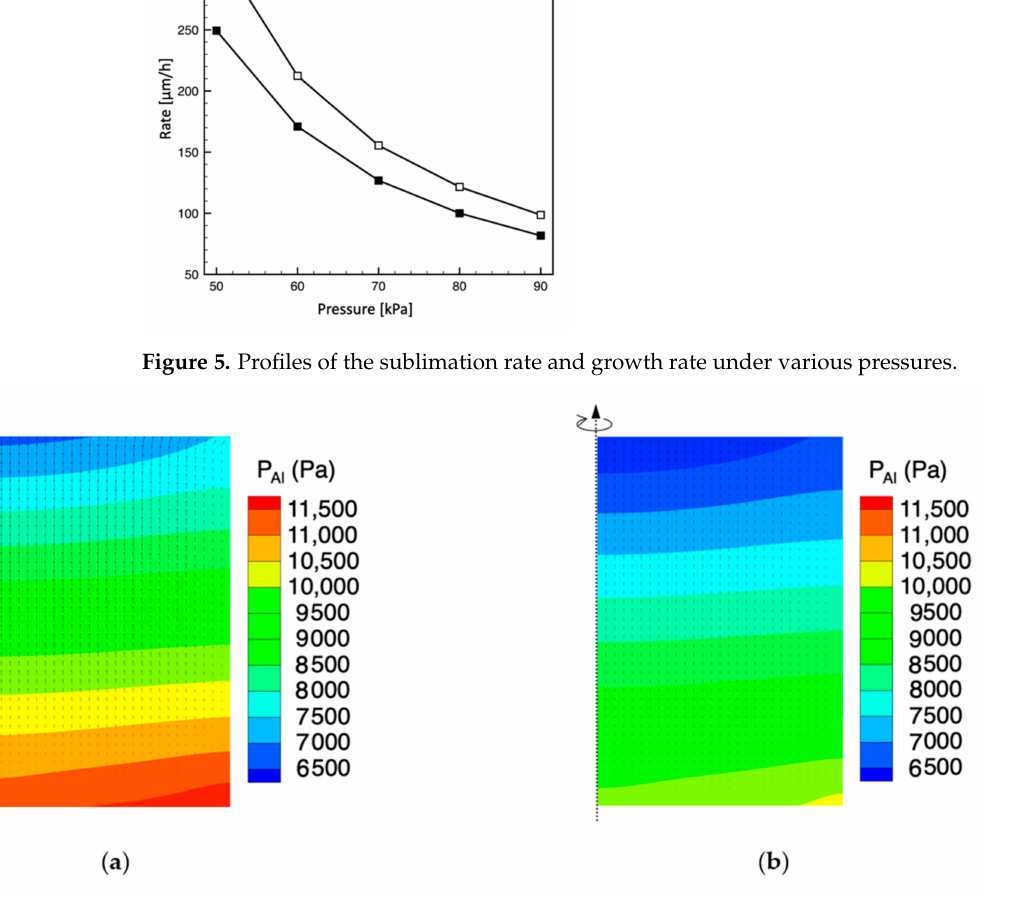
Figure 6. Distribution of mixed flow and Al vapor partial pressure in the growth chamber for pressures of ( a ) 50 kPa and ( b ) 90 kPa.